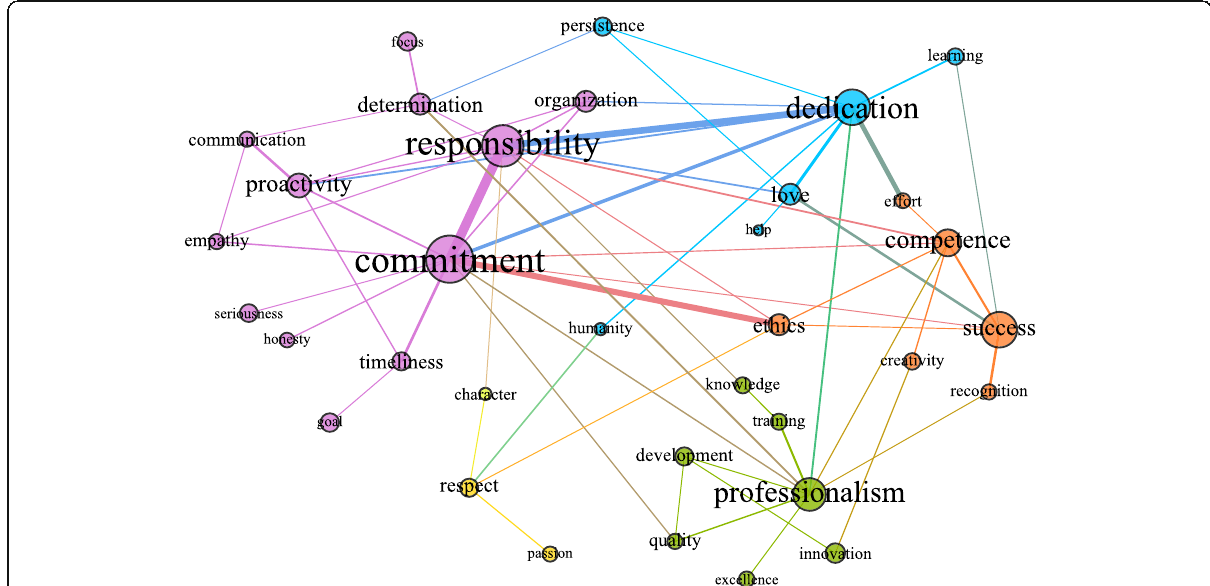
Fig. 3 Semantic network of professional identity for the group of undergraduate students who work in the field . Notes . The colors of the connections between the words represent the communities; the size of the nodes is proportional to their centralities of intermediation, and the thickness of the edges is proportional to the value of the IF